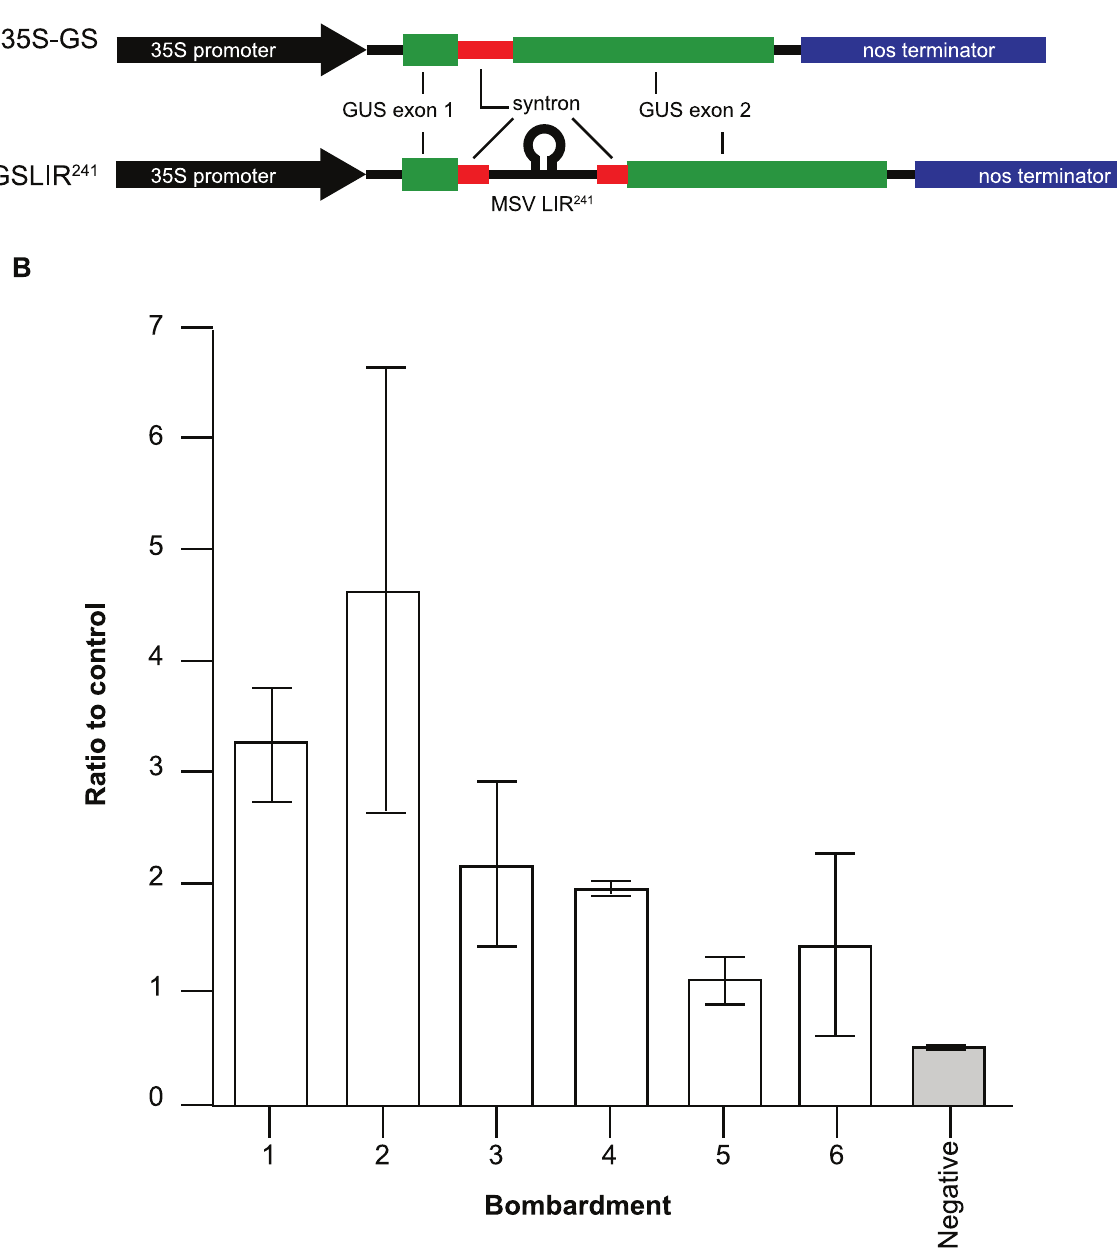
Figure 3. Gus assays to test for cryptic splice sites in the MSV long intergenic region. A) Gus expression cassettes used in the assays. B) Expression of Gus from p35S-GSLIR 241 (test construct) as a ratio to p35S-GS (positive control construct), four days after bombardment. Each bar is an average of three replicates; error bars represent 95% confidence intervals. Negative=negative control (protein extract from a non-bombarded Black Mexican sweet